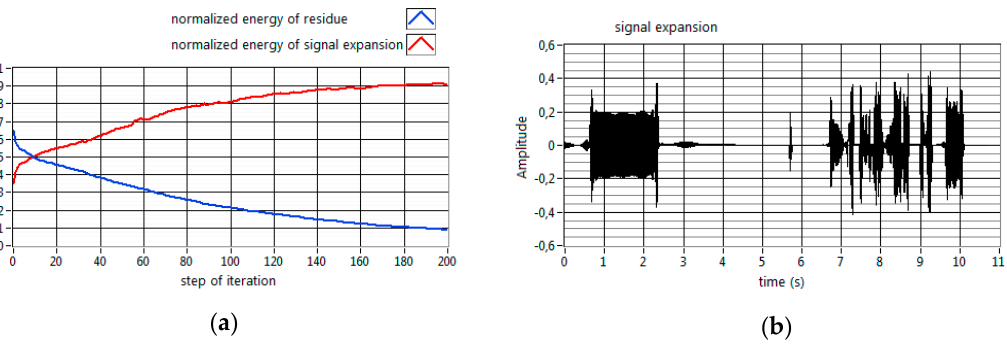
Figure 4. The plots: ( a ) the normalized energy of the residue and the normalized energy of the signal expansion as a function of the iteration steps in the MP algorithm; ( b ) the reconstructed measured signal for dictionary size equal to 200.